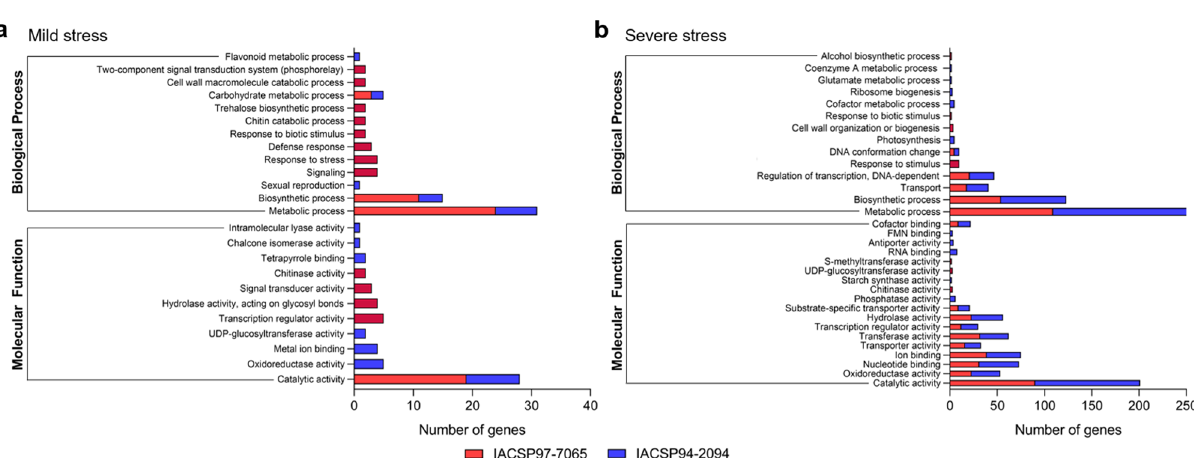
Figure 3. Functional enrichment of differentially expressed genes. Statistically significant enriched GO (Gene Ontology) terms encompassing ‘biological process’ and ‘molecular function’ are represented for the sensitive (IACSP97-7065—red) and tolerant (IACSP94-2094—blue) sugarcane genotypes under ( a ) mild and ( b ) severe drought stress ( p ≤